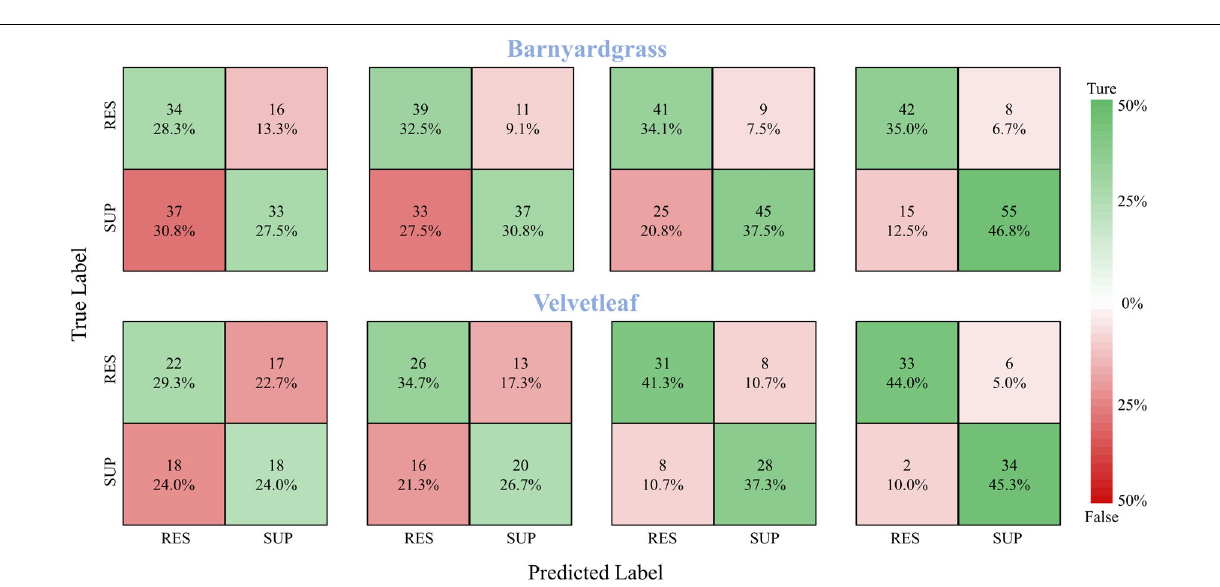
differences, demonstrating the potential of spectral information for the study of resistant